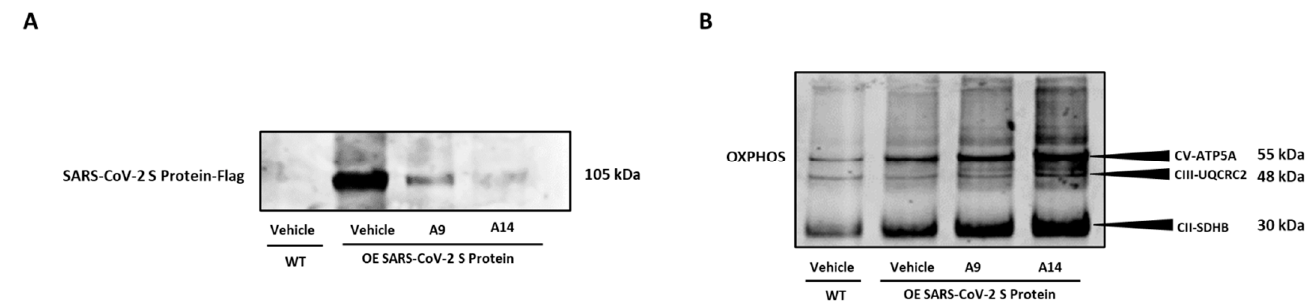
Figure 6. Impact of peptides A9 and A14 on over expressing SARS-CoV-2 S (spike) protein in HEK293T cells. Immunoblots showing the changes in ( A ) SARS-CoV-2 S (spike) and ( B ) OXPHOS levels of HEK293T cells after treatment with A9 and A14 at the tested concentration. HEK293T cells were grown in DMEM complete media containing 10% FBS with antibiotics. The SARS-CoV-2 S (spike) protein was overexpressed in cells. These cells were treated with vehicle (nuclease free water) or A9 or A14 at 50 µM for 24 h. Thereafter, protein was extracted using RIPA buffer and was stored at − 20 °C till further analysis. These experiments were repeated thrice independently. µM: micromolar.